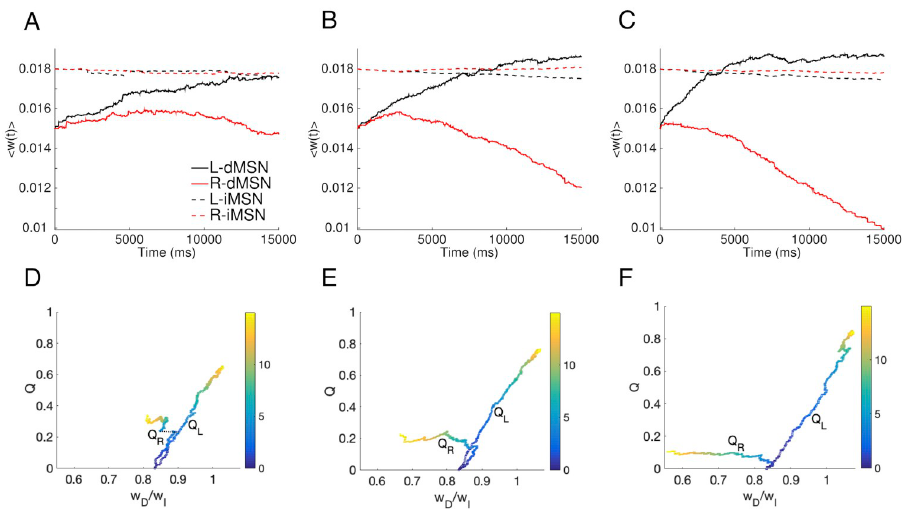
Fig 2. Corticostriatal synaptic weights with probabilistic reward feedback. First column: p L = 0.65; second column: p L = 0.75; third column: p L = 0.85 A, B, and C: Averaged weights over each of four specific populations of neurons, which are dMSN neurons selecting action L (solid black); dMSN neurons selecting action R (solid red); iMSN neurons countering action L (dashed black); iMSN neurons countering action R (dashed red). D, E, and F: Evolution of the estimates of the values for actions L ( Q ) and R ( Q ) estimated by Q-learning versus the ratio of the corticostriatal L R weights to those dMSN neurons that facilitate the action relative to the weights to those iMSN that interfere with the action. Both the weights and the ratios have been averaged over 8 different realizations. A small jump occurs in the Q R trace for p L = 0.65 and is joined by a dashed line; this comes from the time discretization and averaging.